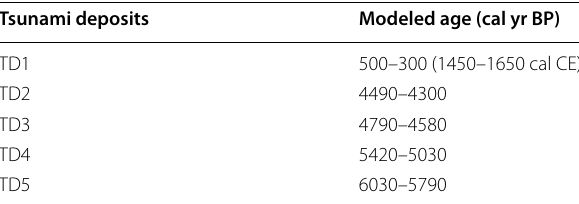
Table 6 Modeled ages of TD1–TD5 Tsunami